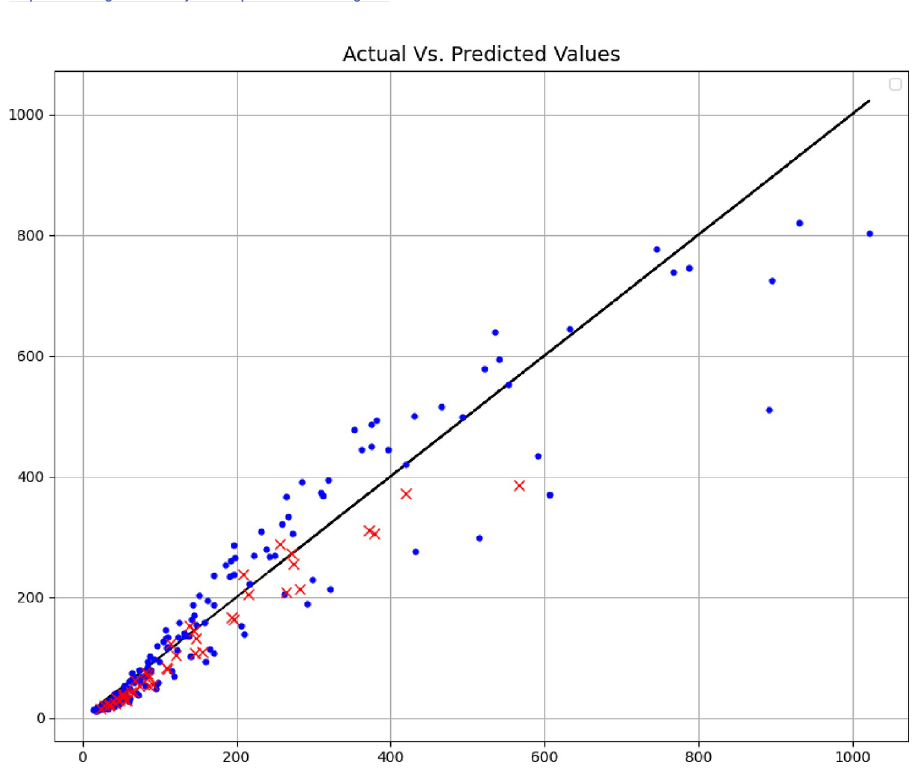
Fig 5. Actual Vs. estimated outputs (GRNN model).